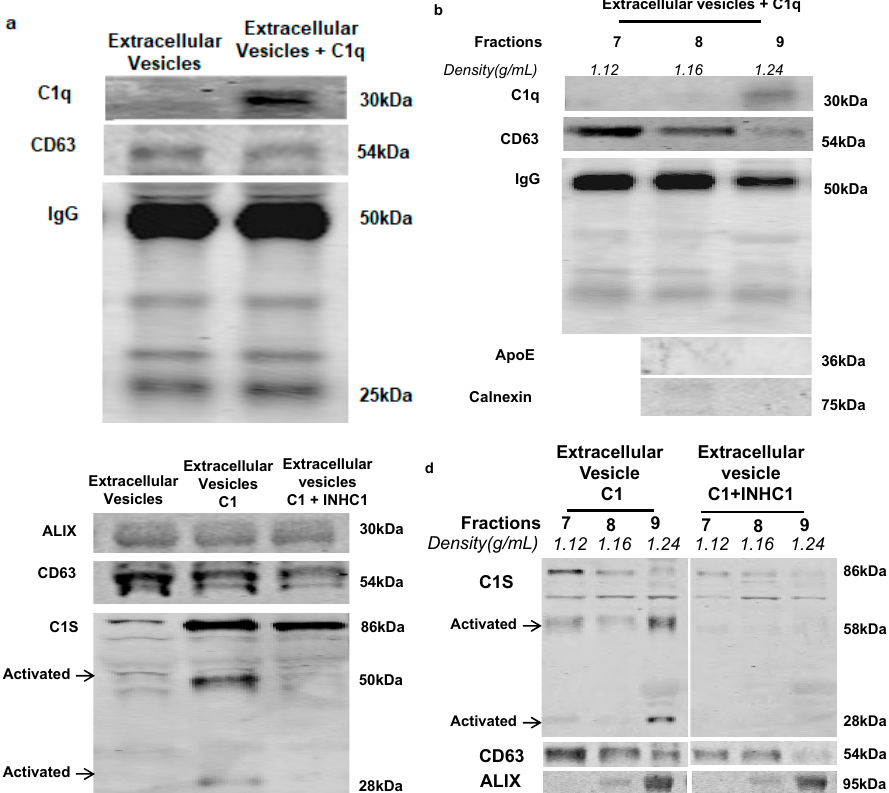
Figure 2. Western blot analysis of complement activation with rat plasma extracellular vesicle isolated via ultracentrifugation and purified by OptiPrep density gradient. ( a ) Binding of human complement protein, C1q, to ultracentrifugation isolated rat plasma extracellular vesicles. ( b ) C1q specifically bound to rat plasma extracellular vesicles with density at 1.24 g/mL (fraction 9). This fraction was negative for ApoE and Calnexin. ( c ) C1 activation assay showed that C1 was activated by ultracentrifugation-isolated rat plasma extracellular vesicles (middle-lane) and C1 activity was inhibited in the presence of C1 inhibitor (INHC1) (right-lane). ( d ) Incubating C1 complex with rat plasma extracellular vesicles followed by fractionation using OptiPrep density gradient showed that C1 complex bound to extracellular vesicle at 1.24 g/mL density (fraction 9) and activated serine protease subcomponent C1s (left), and the activity of the C1s was inhibited by C1 inhibitor (INHC1) (right). All of the experiments were repeated at least three times.